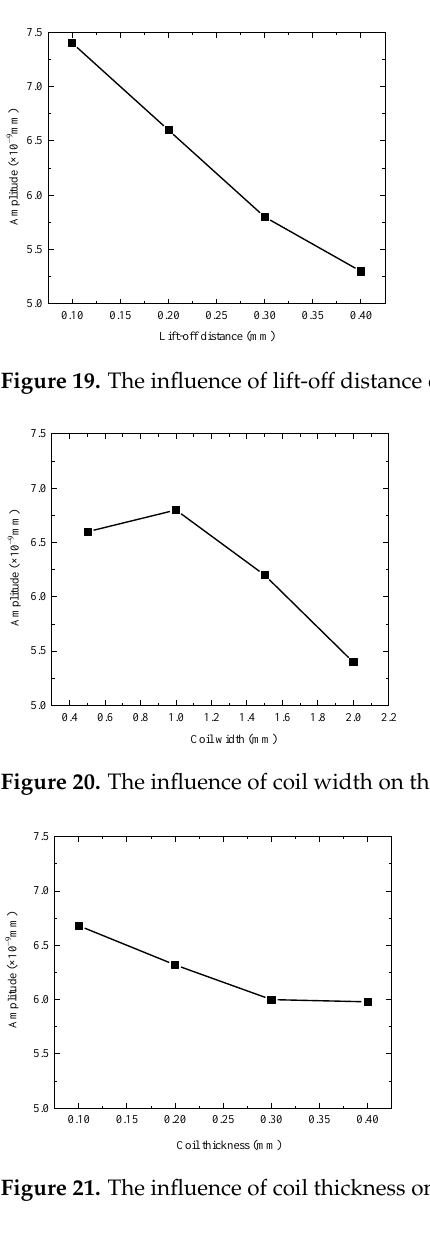
Figure 21. The influence of coil thickness on the amplitude of received signal.